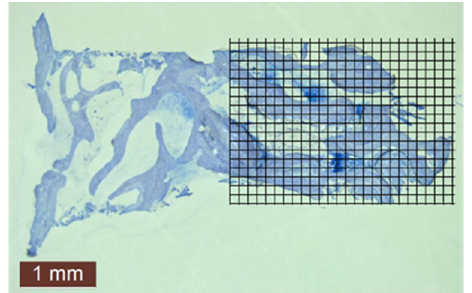
Figure 5. Histomorphometric evaluation of new bone amount by point counting method in case